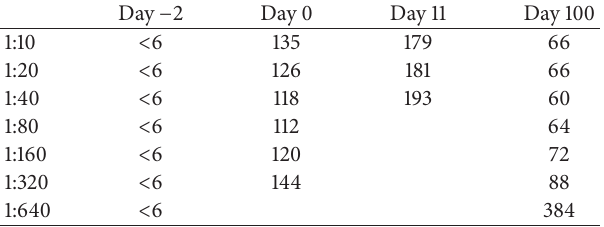
Table 1: Factor VIII dilution